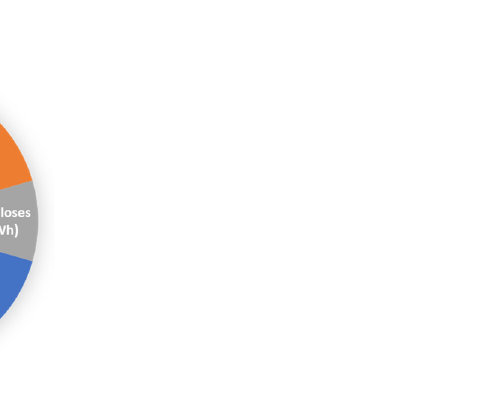
Figure 2. The daily thermal energy demands for the building services system in the heating season.